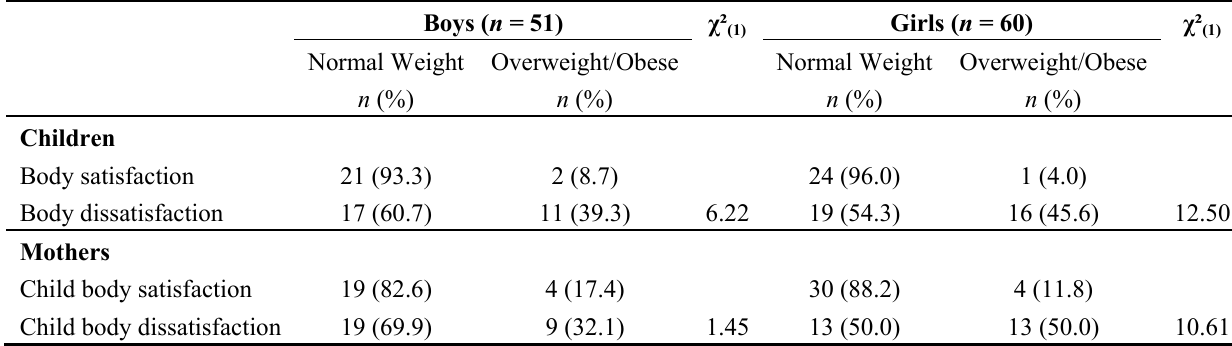
Table 2. Body dissatisfaction in boys and girls according to